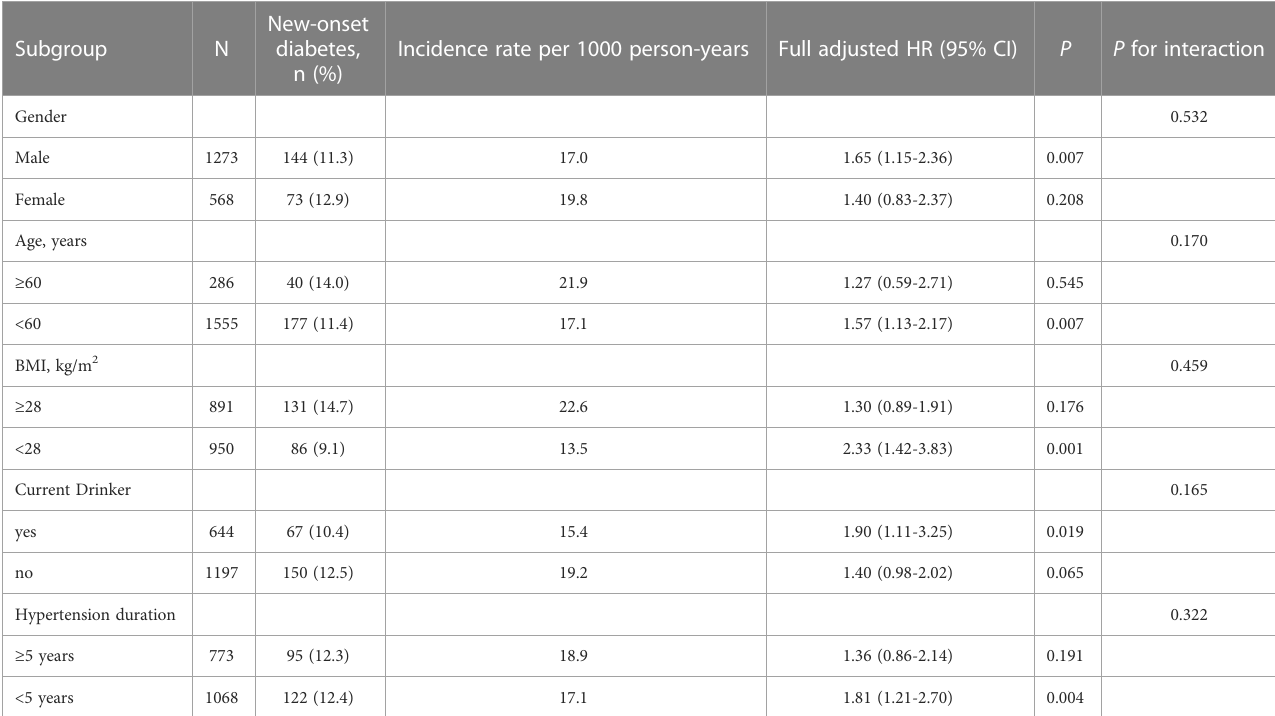
TABLE 3 Association between non-dipping pattern and new-onset diabetes strati fi ed by